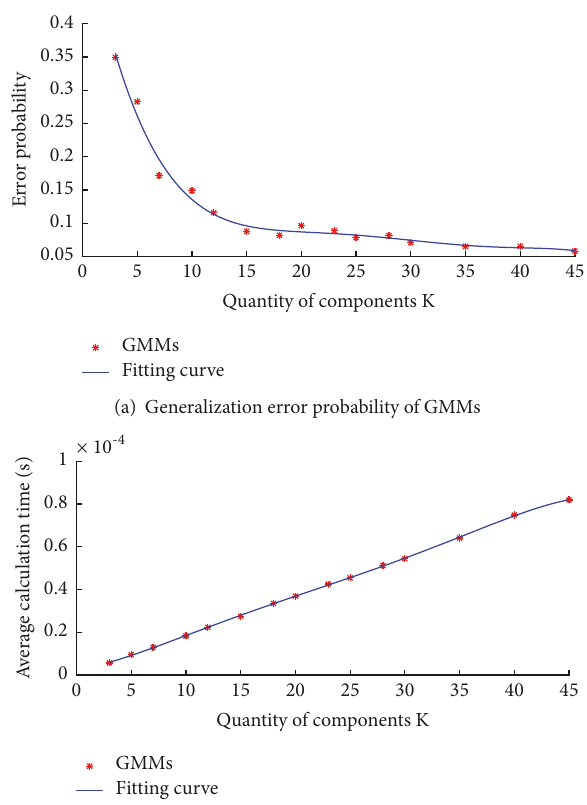
Figure 2: Comparison of the GMMs’ performance under different numbers of